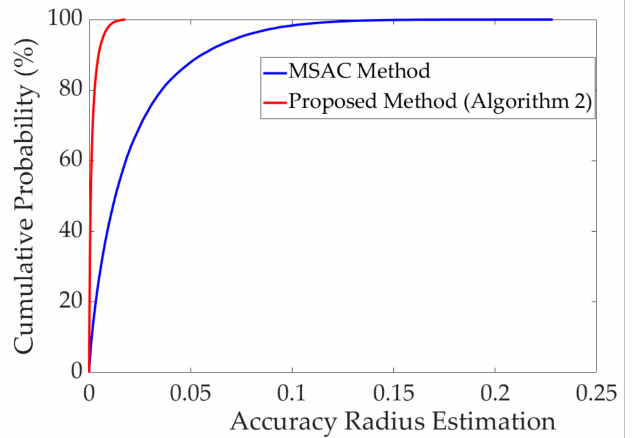
Figure 4. Cumulative probability distribution of the accuracy of the estimated radius of the 50,000 simulated point cloud configurations using the MSAC and proposed